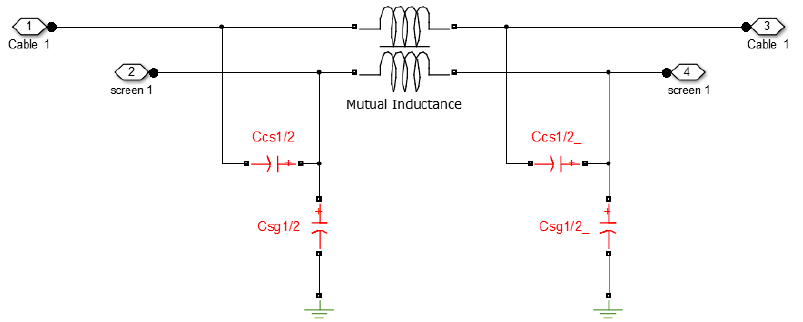
Figure 8. PI model of the cable used in simulations.